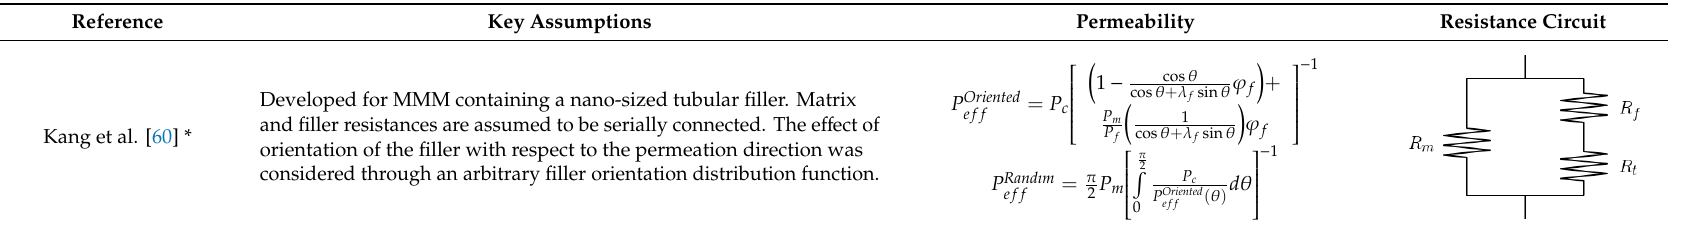
Table 2. E ff ective medium theory-based